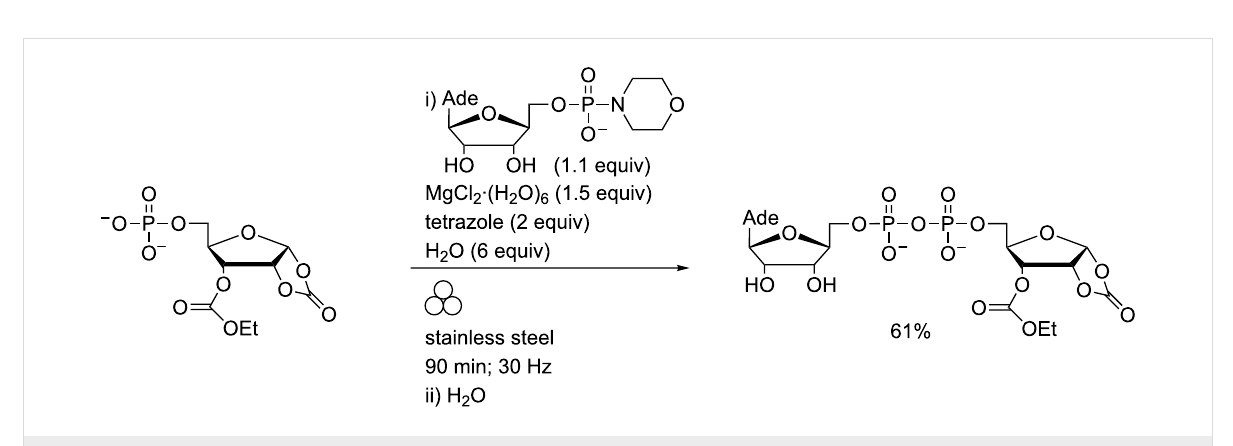
Scheme 14: Preparation of ADPR analogues using in a